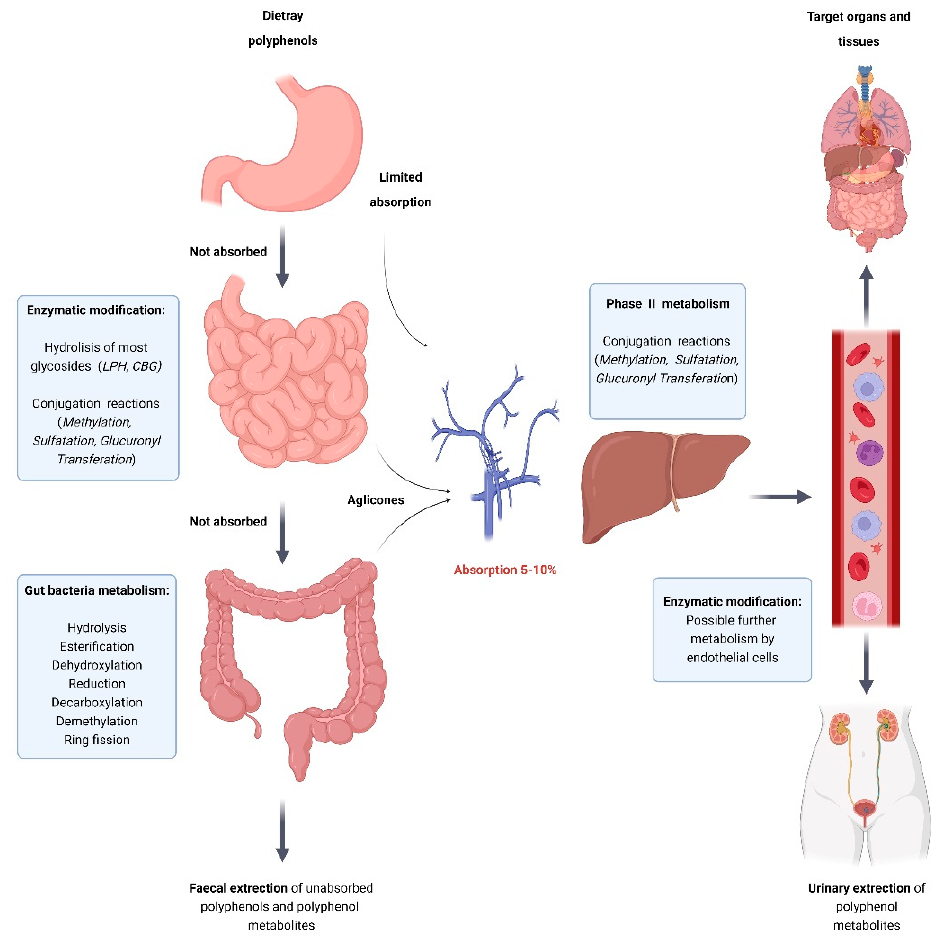
Figure 6. Schematic representation of the absorption and metabolism of food polyphenols (Created with “https://www.biorender.com (accessed on 12 December 2023)”.